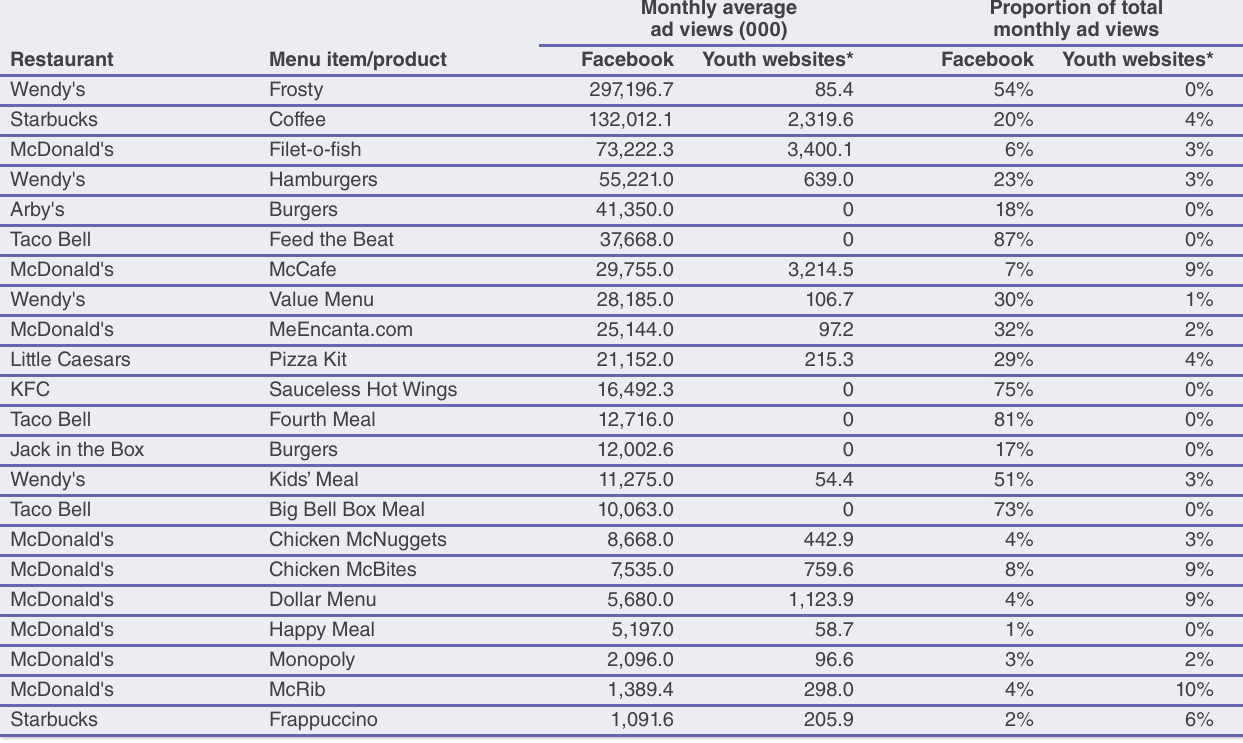
Table 31. Menu items with the most display advertising on Facebook.com and youth